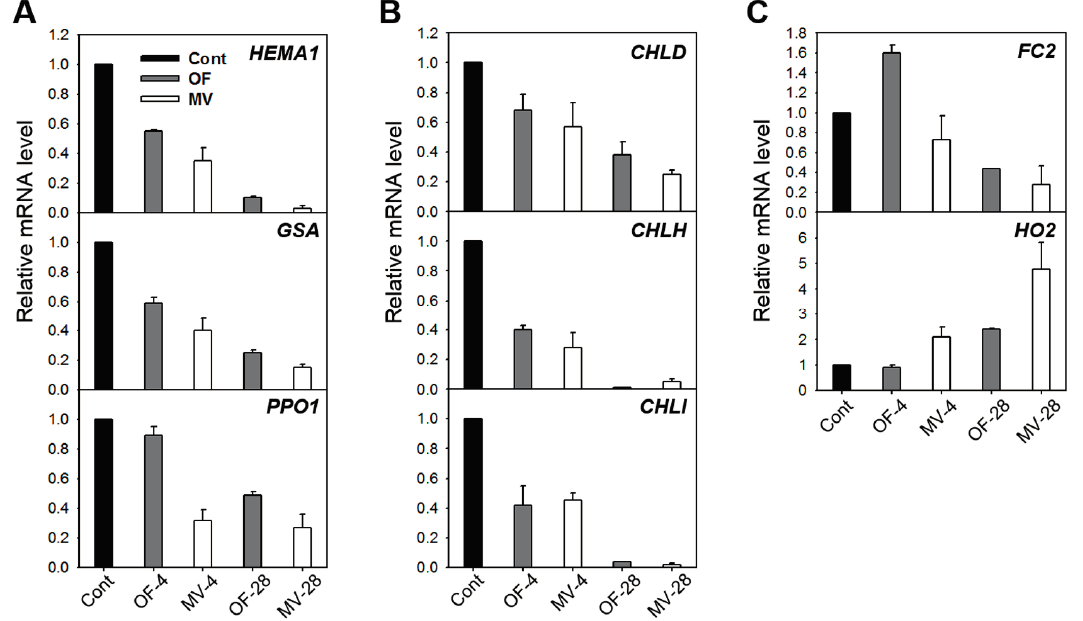
Figure 6. Expression of genes encoding the porphyrin pathway enzymes in rice plants with the foliar application of MV. ( A ) Common branch; ( B ) Mg-porphyrin branch; and ( C ) Fe-porphyrin branch. The plants were subjected to the same treatments as in Figure 2. reverse transcribed. The resultant cDNAs were used as templates for qRT-PCR using Actin the sample set to 1. Error bars represent SE, and representative data from three independent experiments are